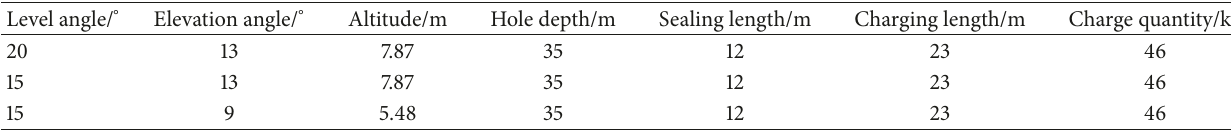
Table 4: Parameters of traditional